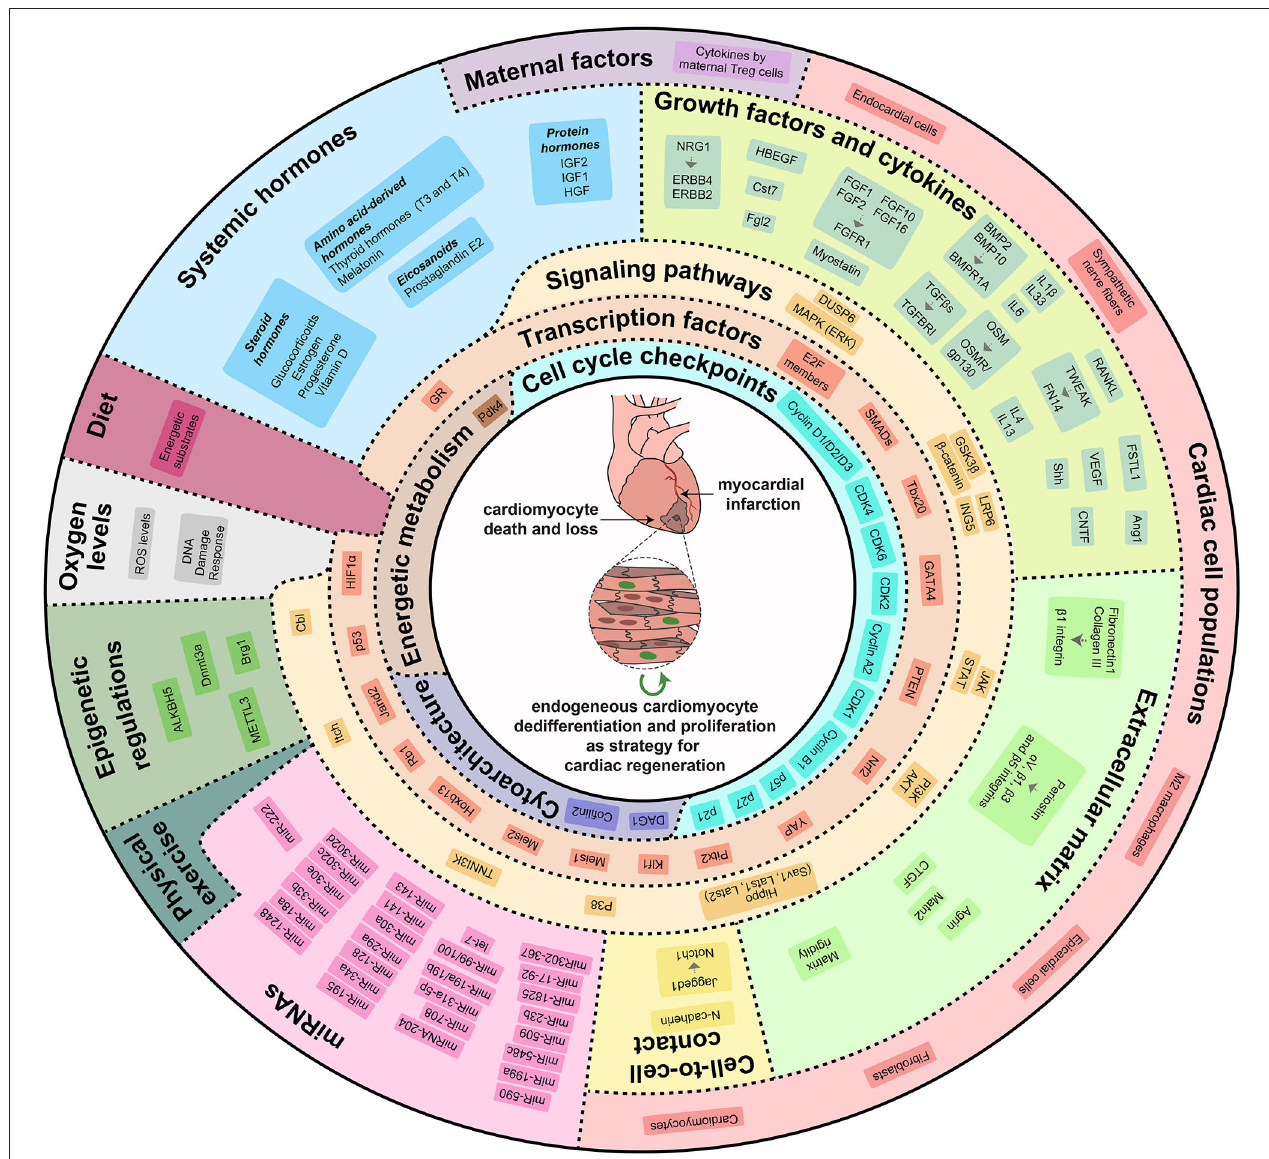
FIGURE 2 | Cardiac regenerative strategies based on direct stimulation of cardiomyocyte dedifferentiation and proliferation. Modulation of external, systemic, micro-environmental, and intrinsic molecular mechanisms can re-activate cardiomyocyte proliferative and regenerative potential. Locally produced growth factors and cytokines, extracellular matrix rigidity and components, direct cell-to-cell contacts, maternal factors, systemic hormones, oxygen levels, physical exercise, miRNAs and epigenetic regulations modulate a variety of signaling pathways and transcription factors that control cardiomyocyte dedifferentiation and proliferation by regulating cell cycle checkpoints, cytoarchitectural organization and energetic metabolism.